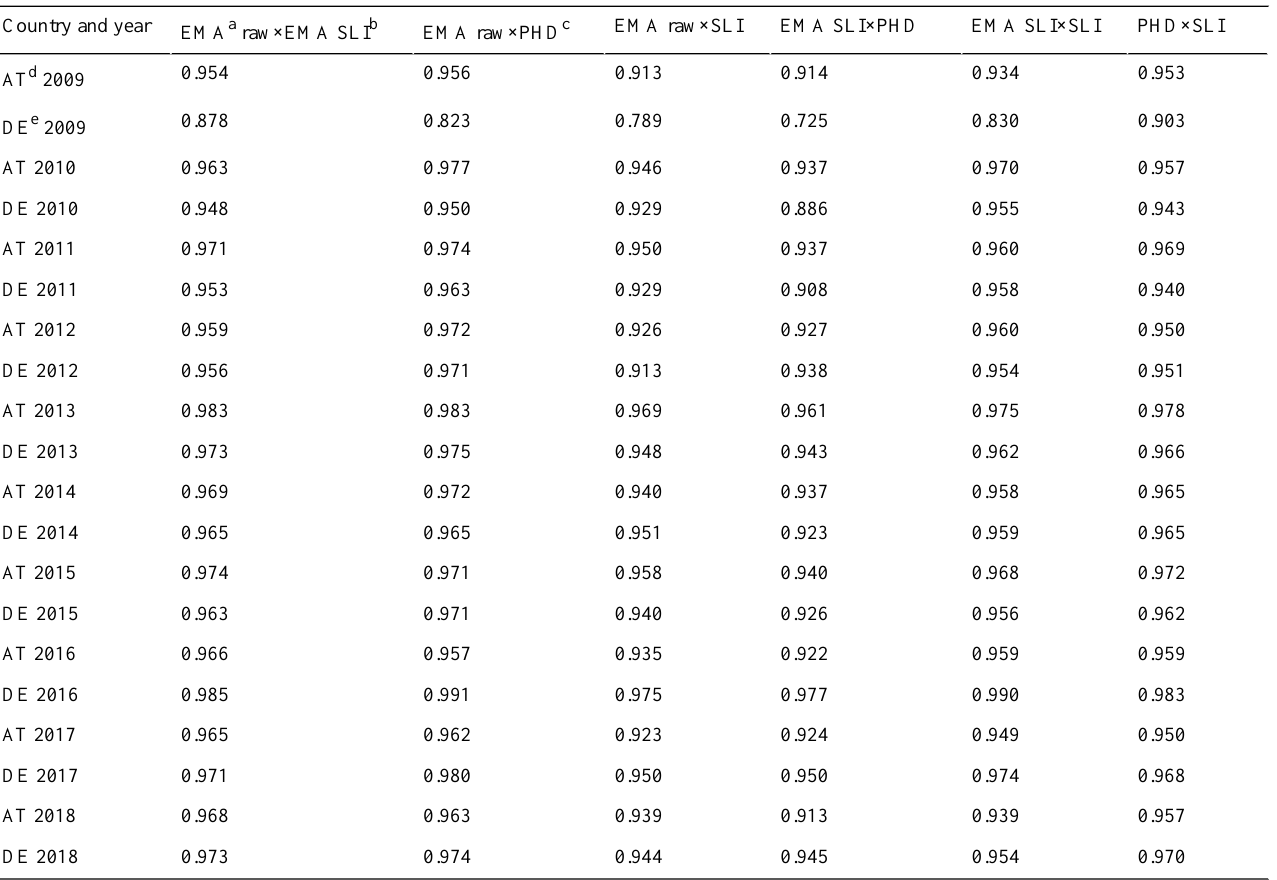
Table 4. Pearson correlation coefficients for the grass (Poaceae) pollen season for the 4 symptom score calculation methods for Austria and Germany from 2009 to 2018. Note the high correlation values for every